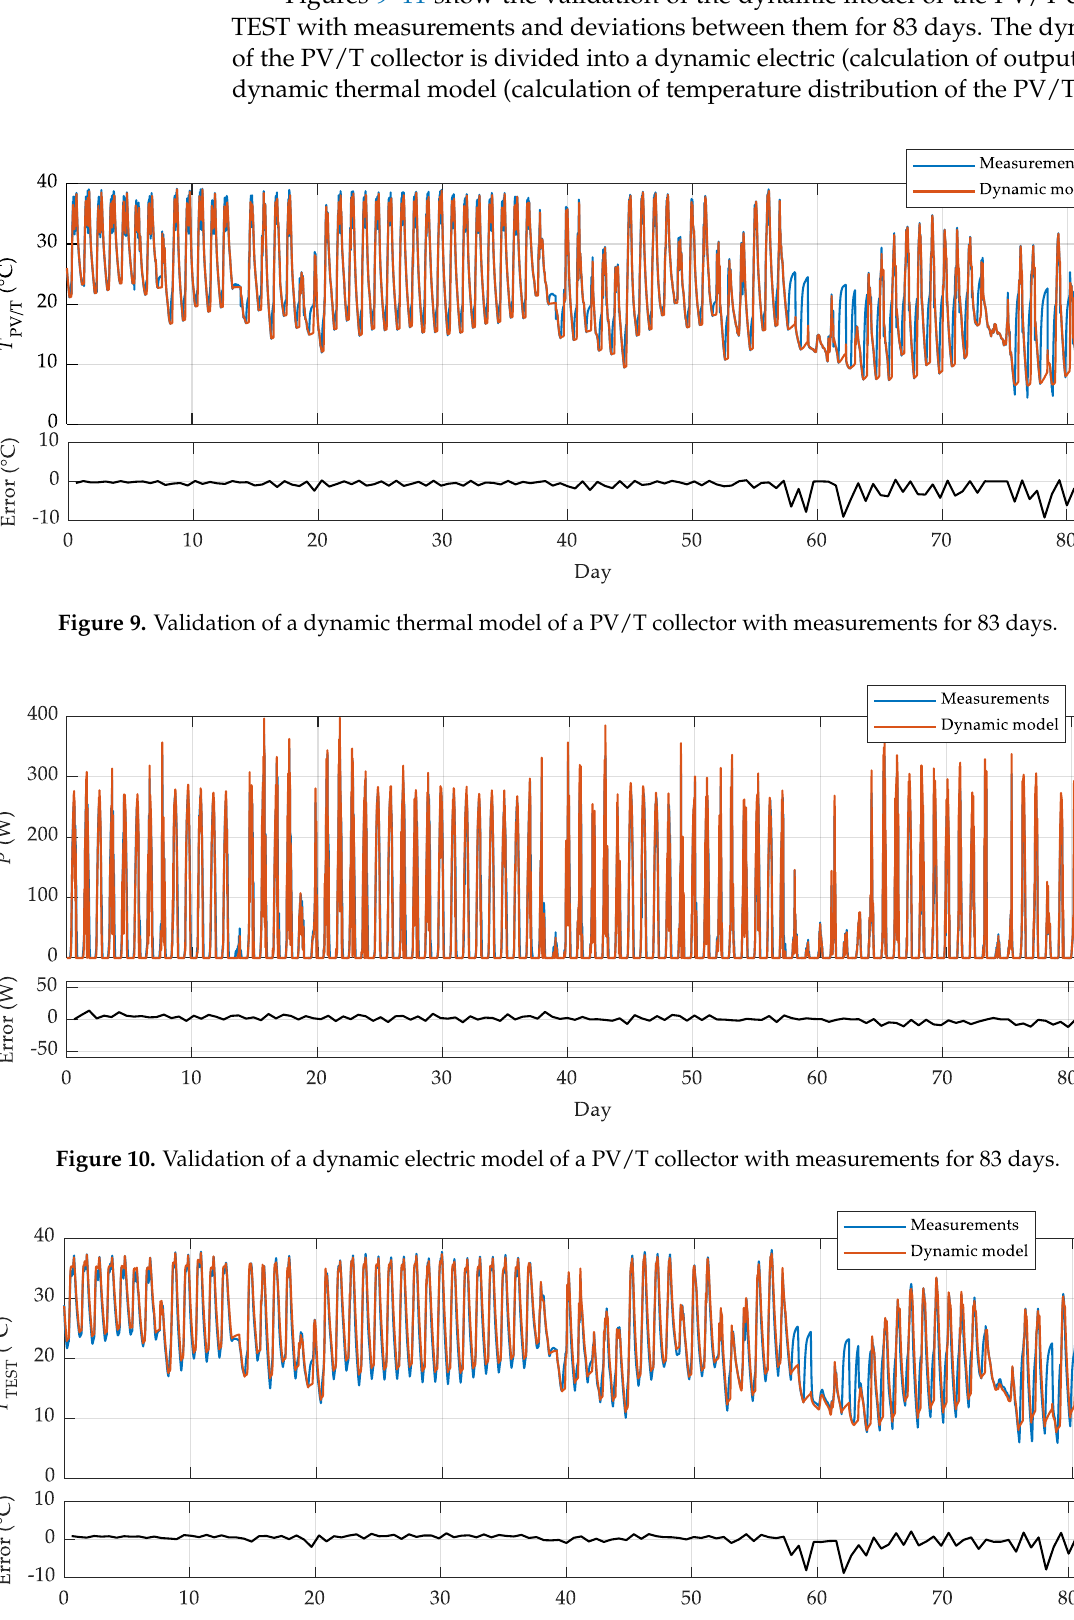
Figure 8. Thermal properties of the working medium as a function of temperature [summarized by 64].